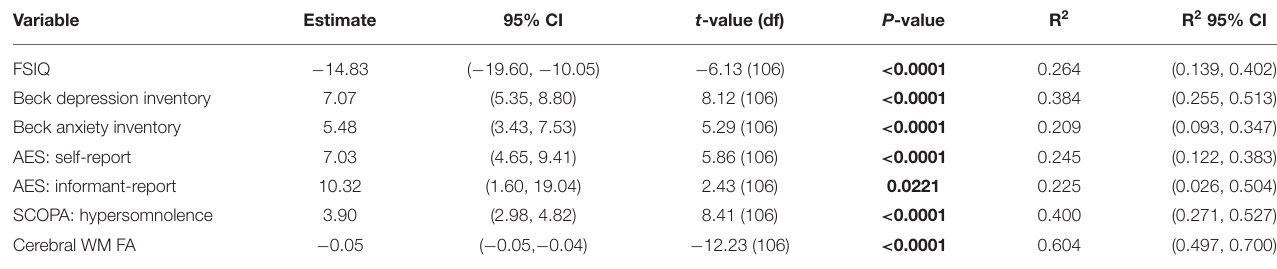
TABLE 2 | Clinical outcome comparisons between groups a . Variable